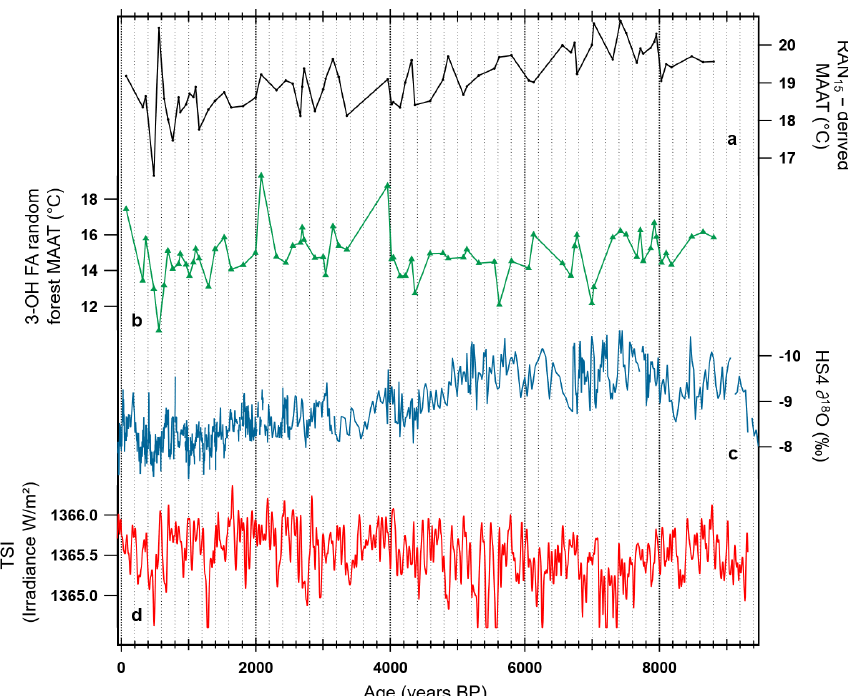
Figure 10. Comparison of the 3-OH FA model–MAAT record with other time series and proxy records for the HS4 speleothem (Wang et al., 2018). (a) RAN 15 –MAAT record reconstructed using a local Chinese calibration (Wang et al., 2016, 2018). (b) 3-OH FA random forest model–MAAT. (c) The CaCO 3 oxygen isotope record (Hu et al., 2008b). (d) Total solar irradiance (TSI; W/m 2 ) during the Holocene (past 9300 years) based on a composite described in Steinhilber et al.